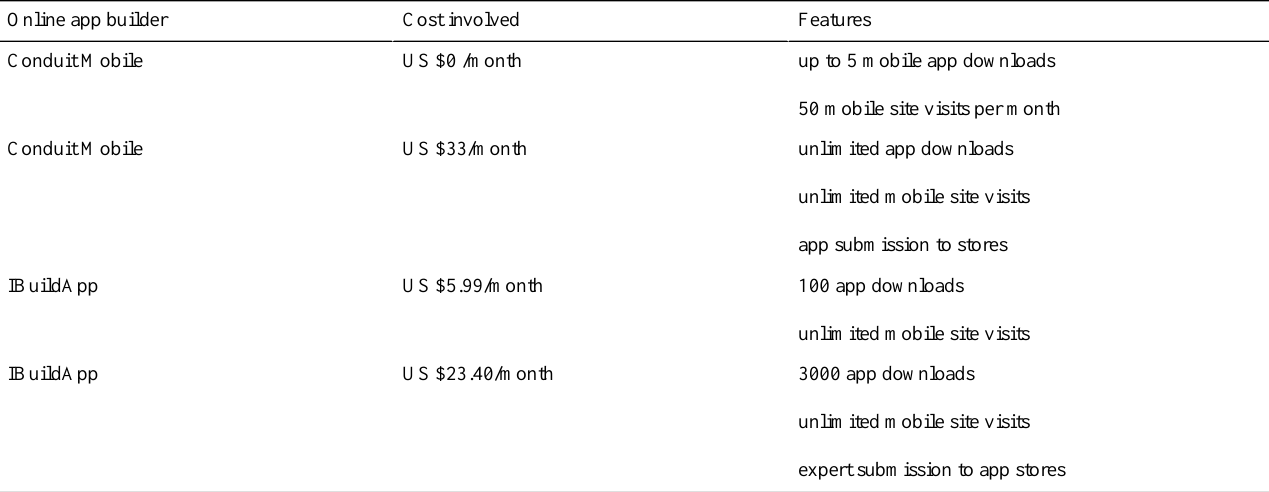
Table 1. Cost of online mobile app